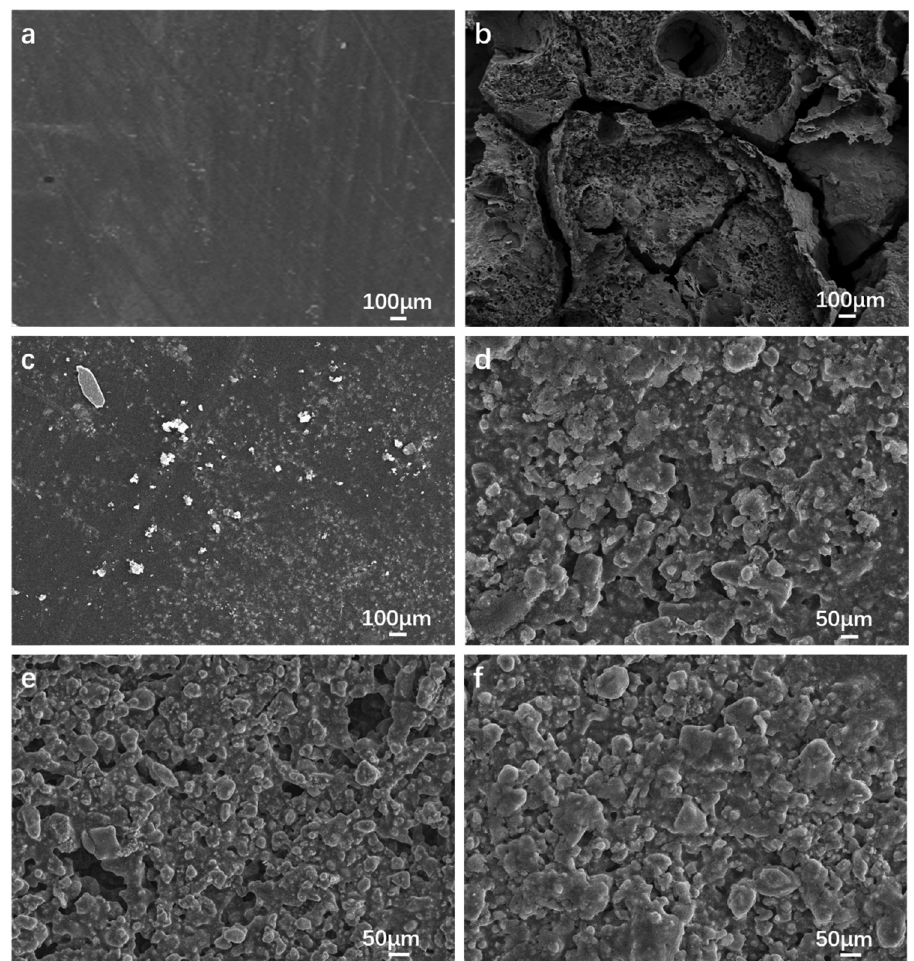
Figure 6: Micromorphology of Ph resin and Z/Ph resin after di ff erent heating times ( a ) Ph - 0, ( b ) Ph - 1, ( c ) Z/Ph - 0, ( d ) Z/Ph - 1, ( e ) Z/Ph - 4, and ( f ) Z/Ph -